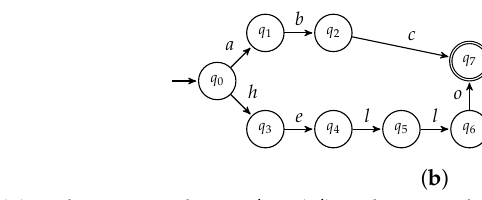
Figure 8. ( a ) A , L ( A ) = { paper , hello } . ( b ) A (cid:48) , L ( A (cid:48) ) = { abc , hello }